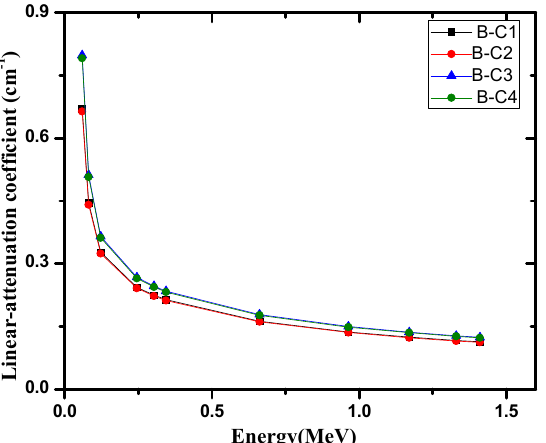
Figure 2. The linear attenuation coefficient of the four investigated samples at different energies.